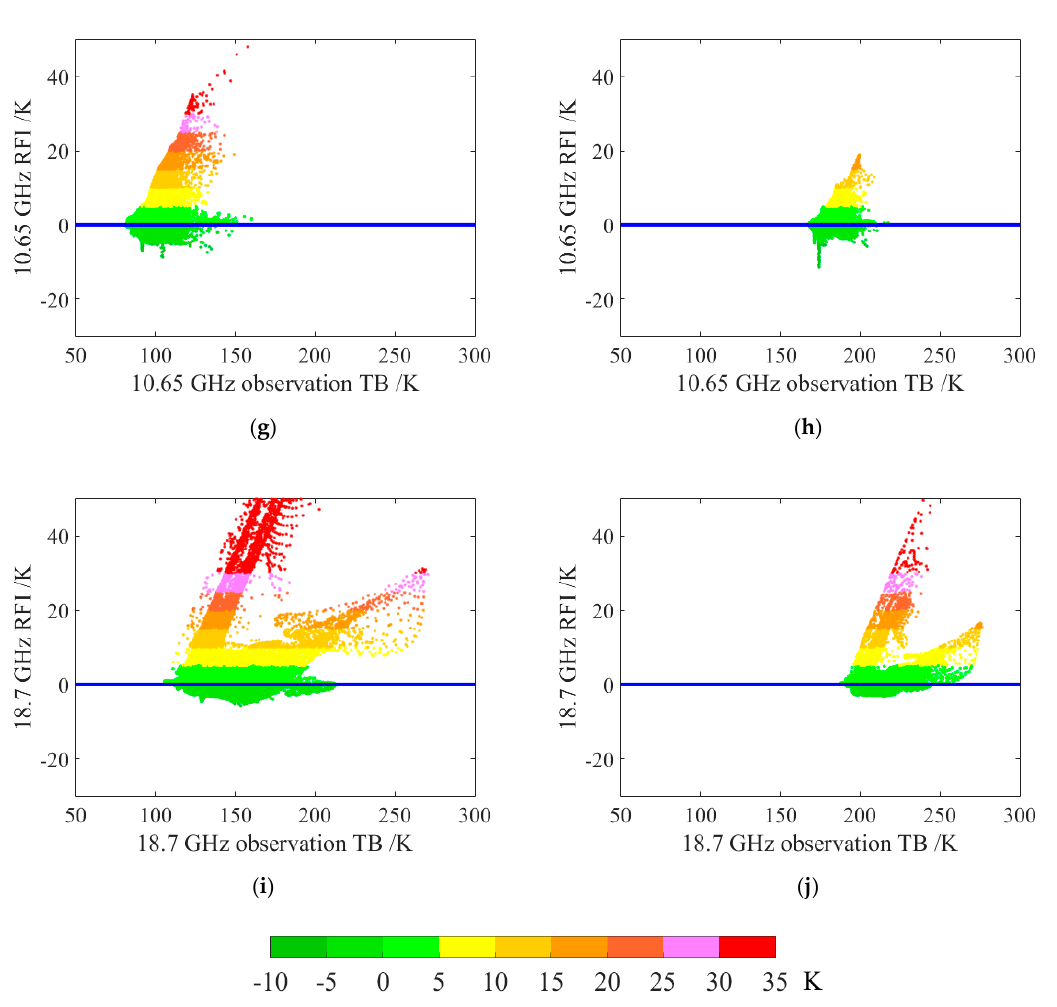
Figure 8. Scatter of RFI and observation TB for H-pol (left panels) and V-pol (right panels), using GRDM. ( a , b ) 12 July; ( c , d ) 11 July; ( e , f ) 12 July; ( g , h ) 7 July; ( i , j ) 14 July.